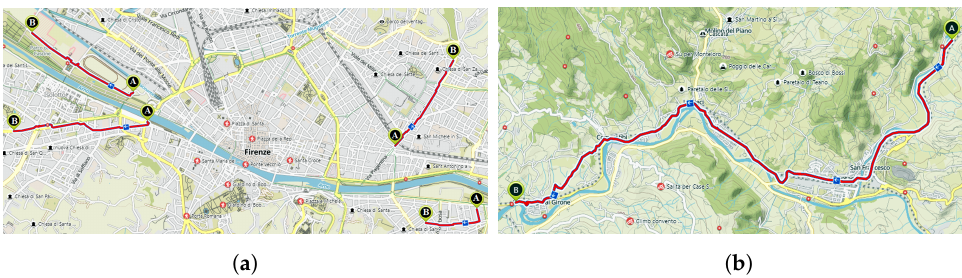
Figure 5. Maps of the acquisition scenarios in Florence. ( a ) Urban scenario; ( b ) Suburban